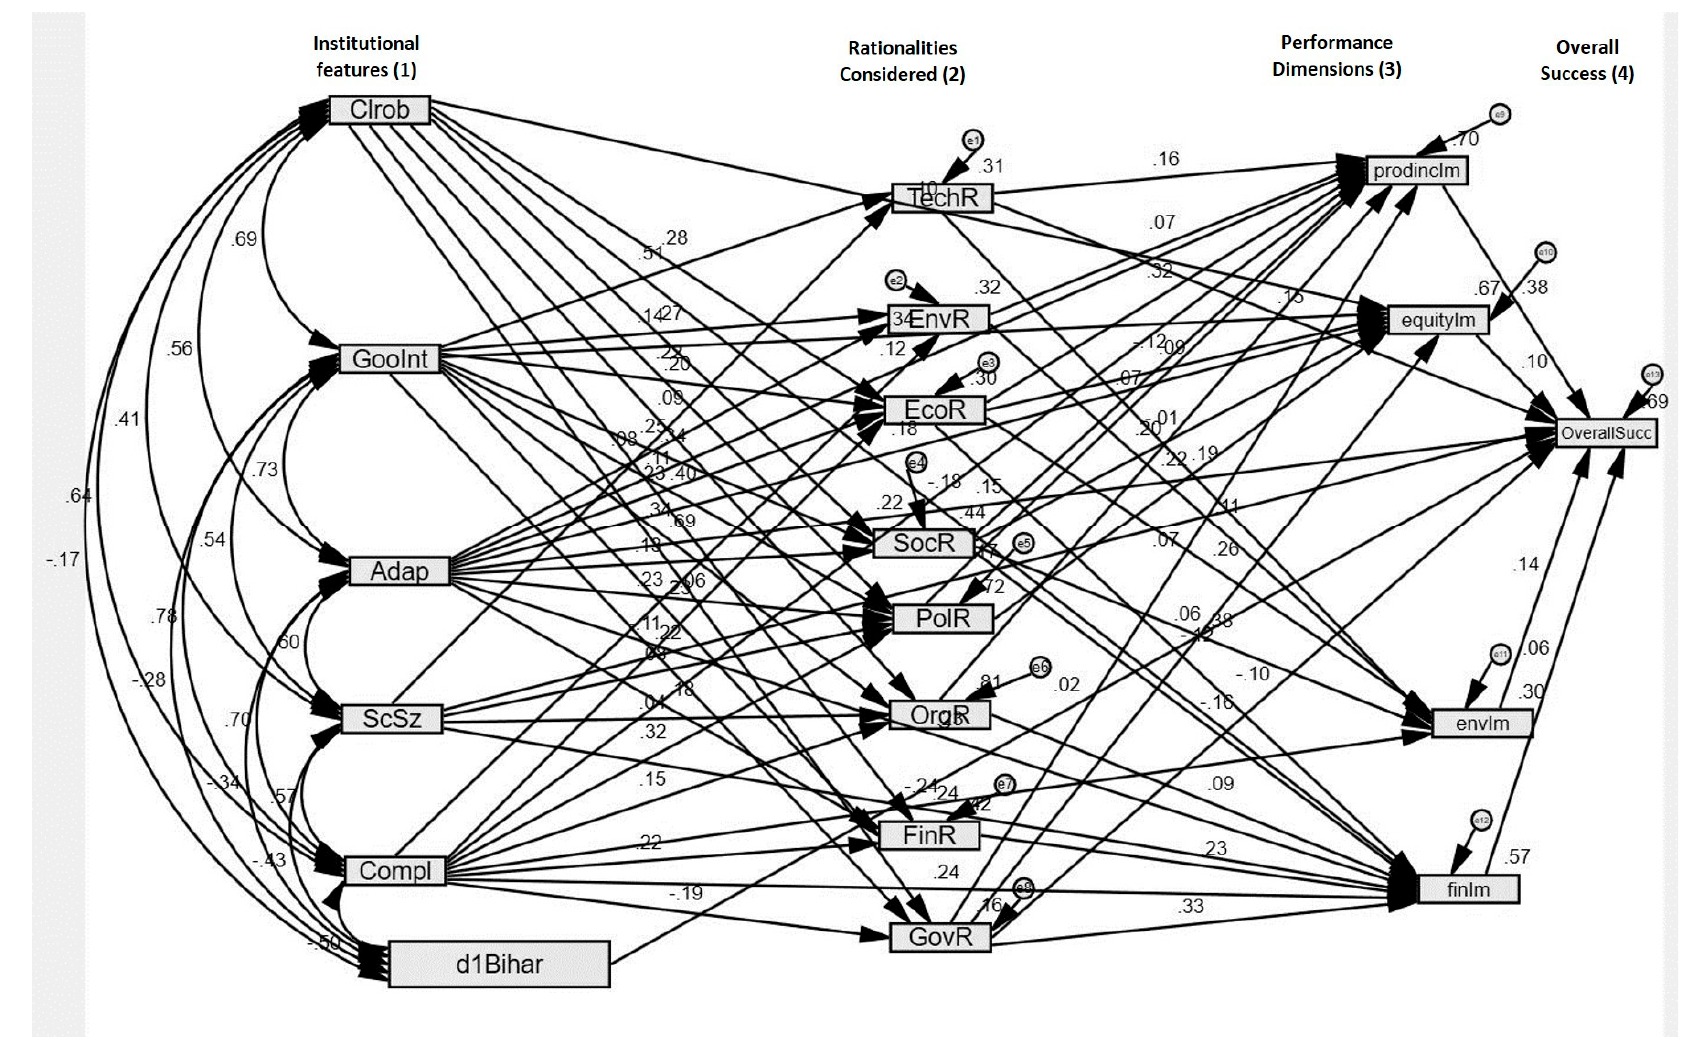
Figure 2. Structural equation modelling (SEM) model.